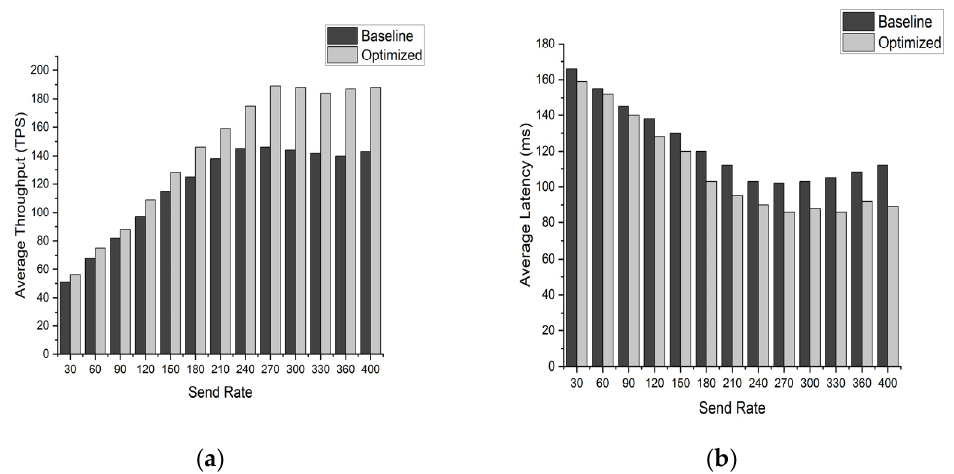
Figure 8. Average transaction throughput ( a ) and latency ( b ) with one TSO and two DSO.